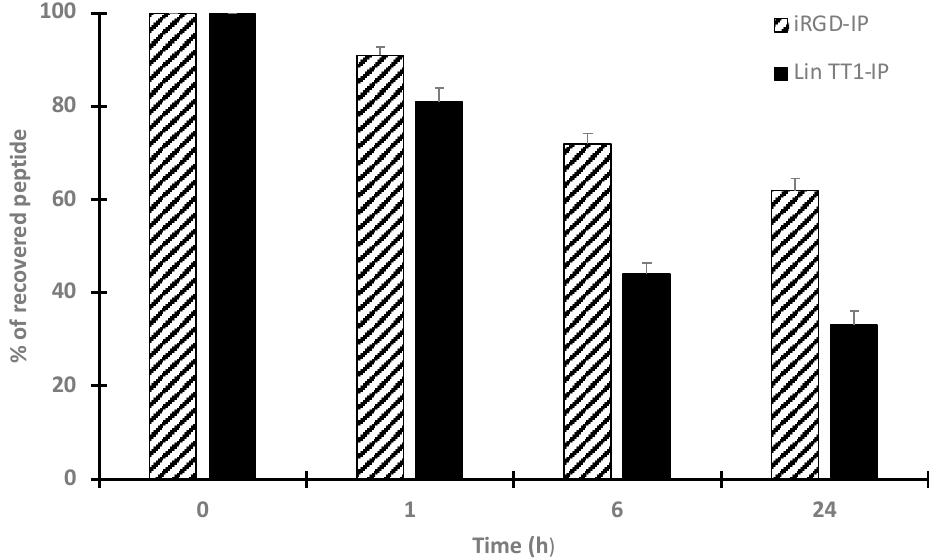
Figure 6. Stability of the peptides in human serum. iRGD-IP and Lin TT1-IP were incubated in human serum at 37 ◦ C for different periods of time. The integrity of the peptide was analyzed by mass spectrometry (MS). The percentage of the recovered peptide over time is presented in the figure. Every measurement was performed in triplicate. Each value is represented as the mean ± standard deviation (SD). Similar results were obtained in two independent